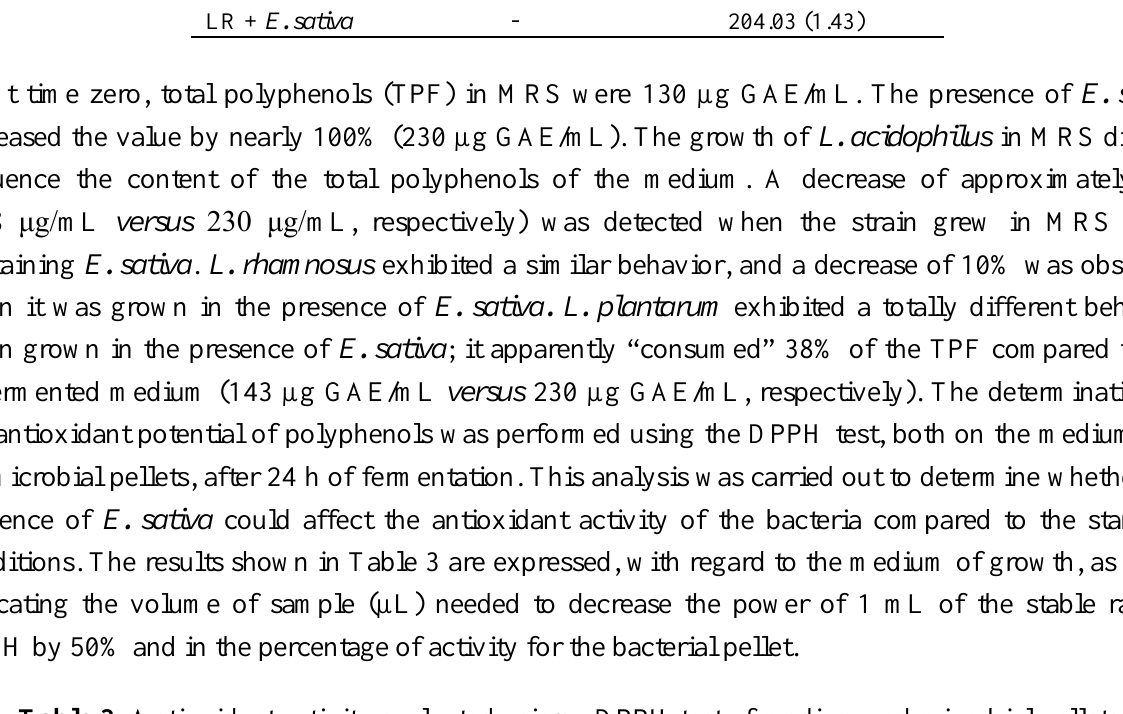
Table 3. Antioxidant activity evaluated using a DPPH test of medium and microbial pellets of L. acidophilus (LA), L. plantarum (LP) and L. rhamnosus (LR) grown in MRS or MRS + E. sativa . The data are expressed in terms of EC 50 , the amount (as µL) of sample needed to decrease the activity of 1 mL of the stable radical DPPH by 50%. The data represent the mean (±standard deviation) of three independent